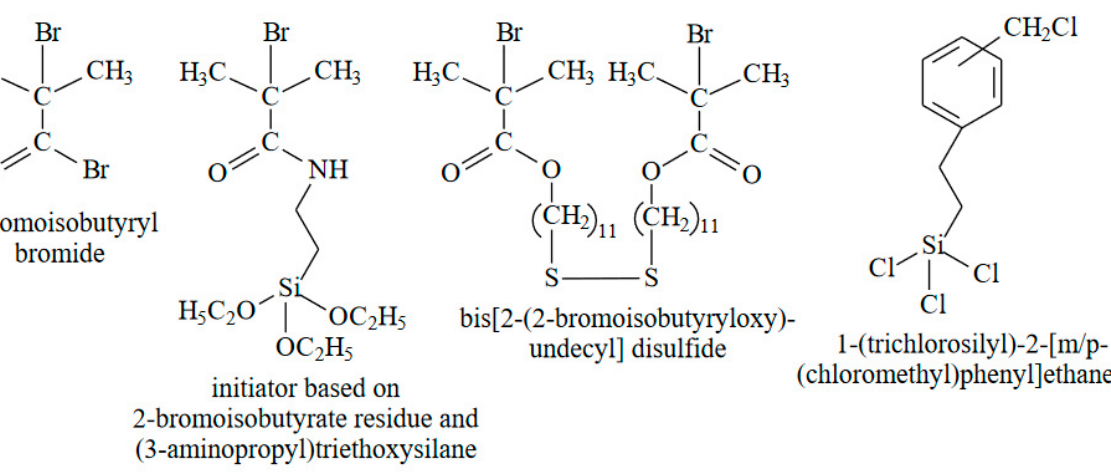
Figure 5. Typical multifunctional initiators for SI-ATRP.